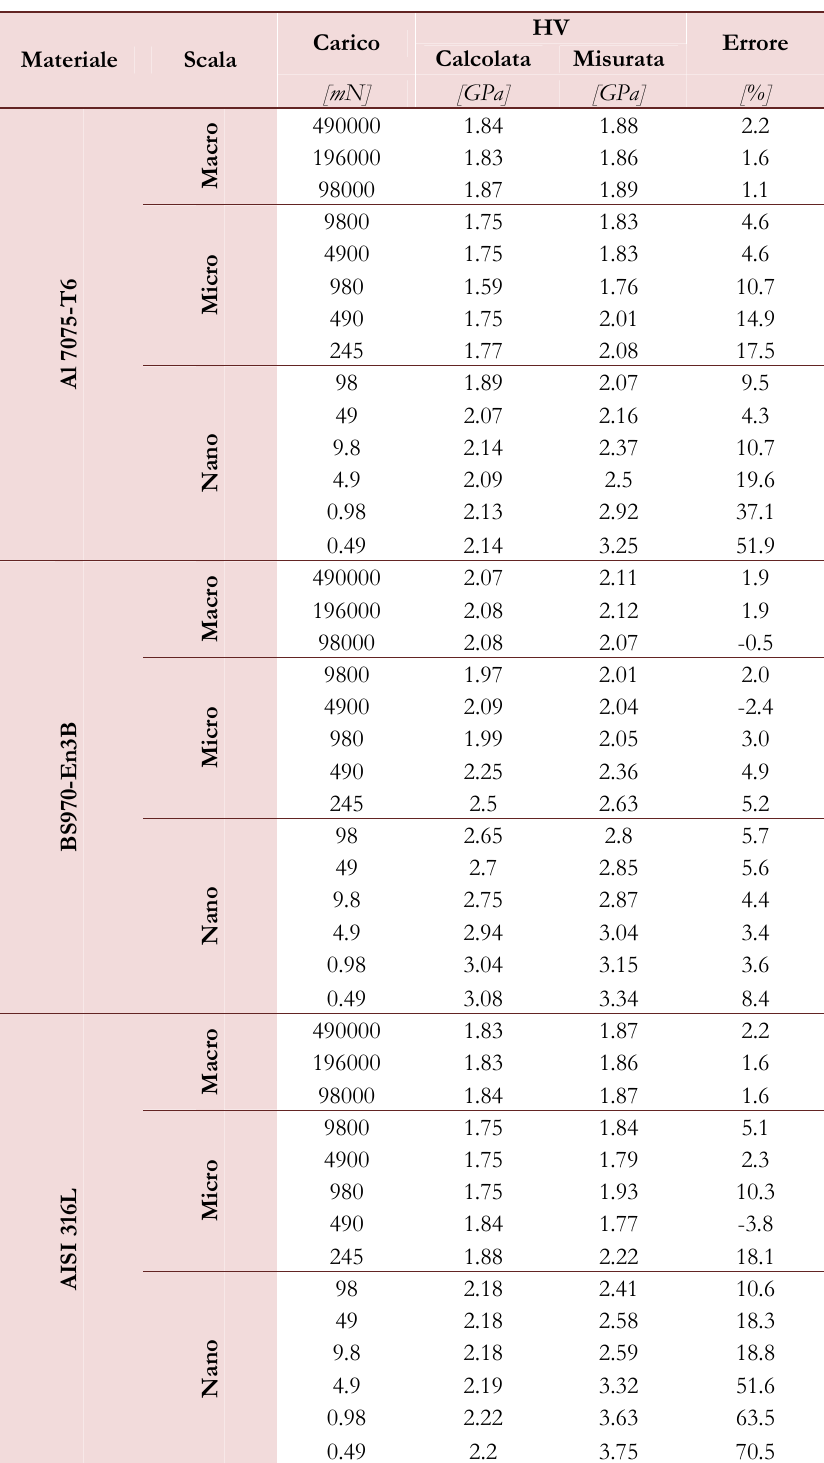
Table 3: Comparison between the experimental values of the Vickers hardness and the corresponding values determined by solving elasto-plastic FE